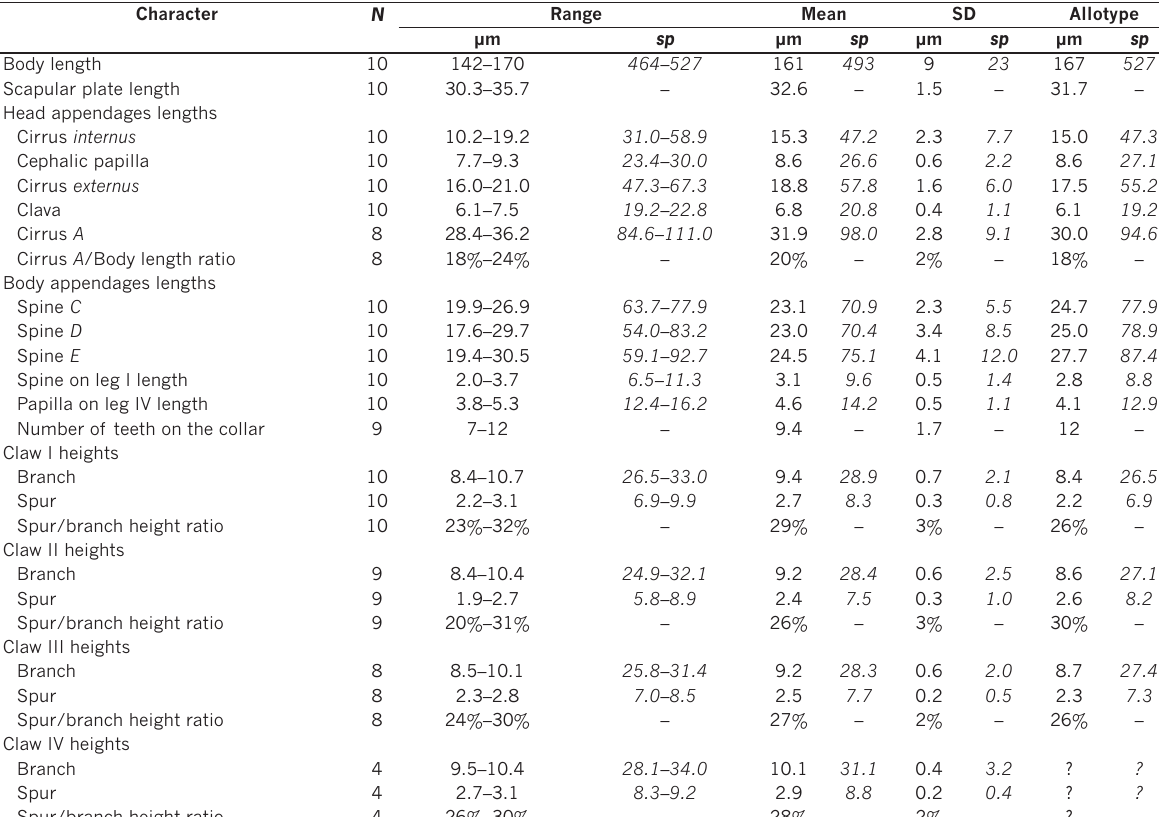
Table 3. Measurements [in µm] of selected morphological structures of the adult males of Echiniscus masculinus sp. nov. mounted in Hoyer’s medium. N – number of specimens/structures measured, RANGE refers to the smallest and the largest structure among all measured specimens; SD – standard deviation; sp – the proportion between the length of a given structure and the length of the scapular plate.